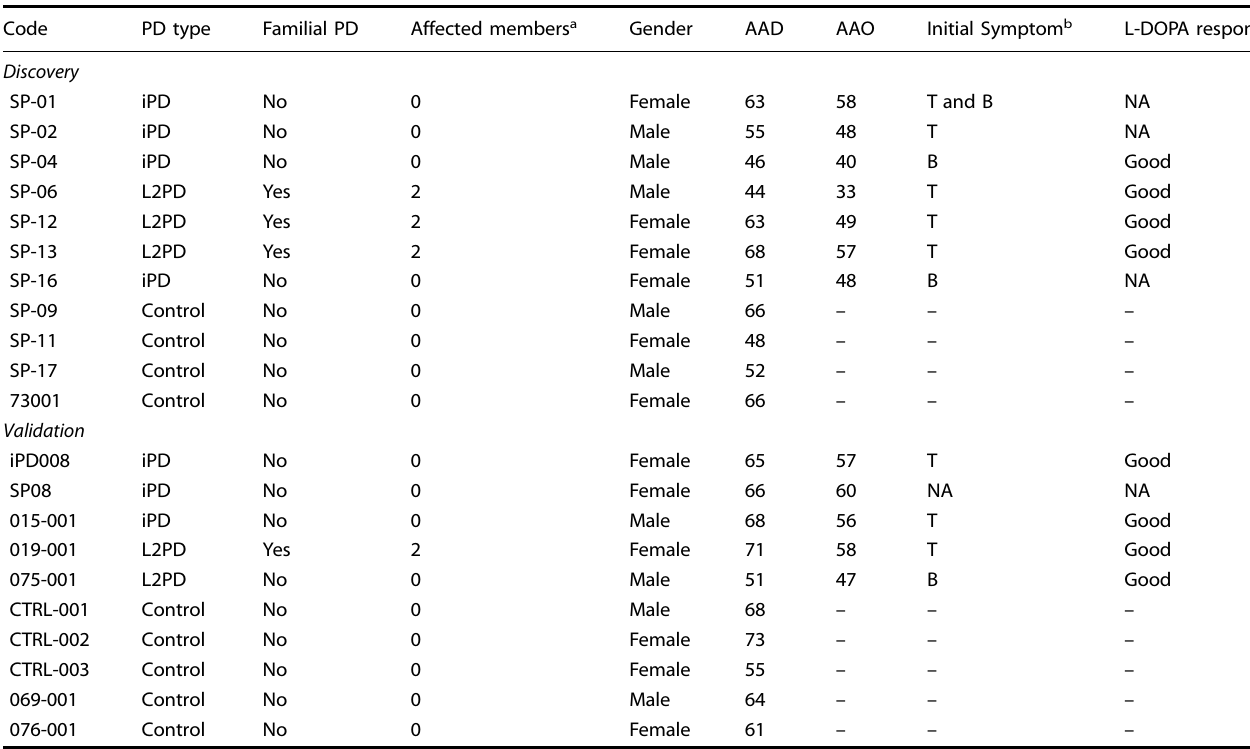
Table 2. Summary of subject clinical features from Parkinson ’ s disease (PD) patients and